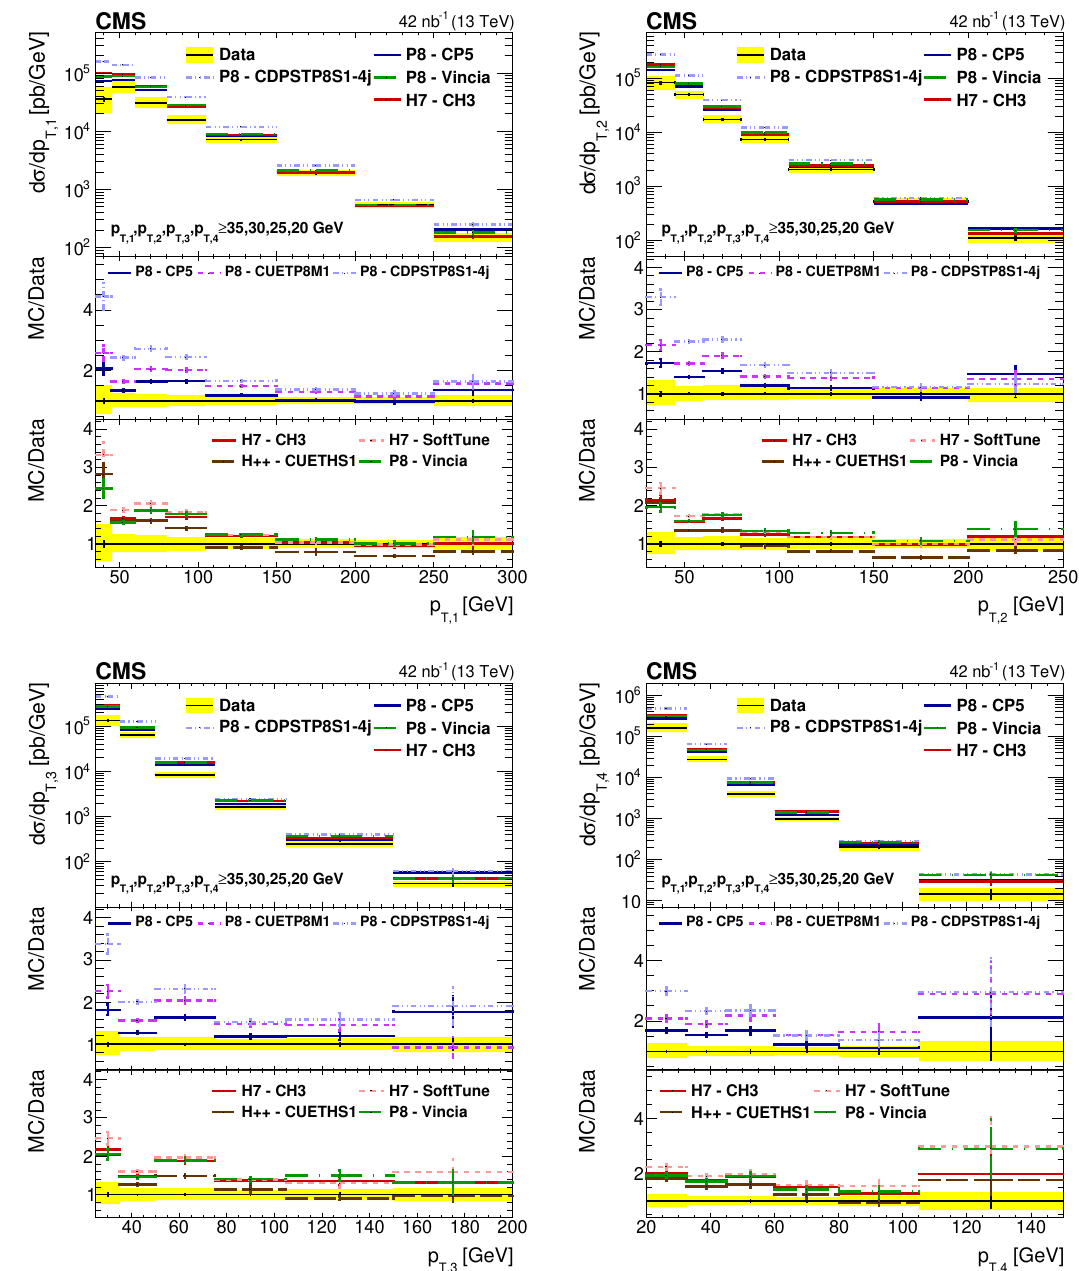
spectra from data to different pythia 8 (P8), herwig++ (H++), Figure 2 . Comparison of the p T and herwig 7 (H7) tunes, for the leading (upper left), subleading (upper right), third leading (lower left), and fourth leading (lower right) jet in Region I. The error bars represent the statistical uncertainty, and the yellow band indicates the total (statistical+systematic) uncertainty in the